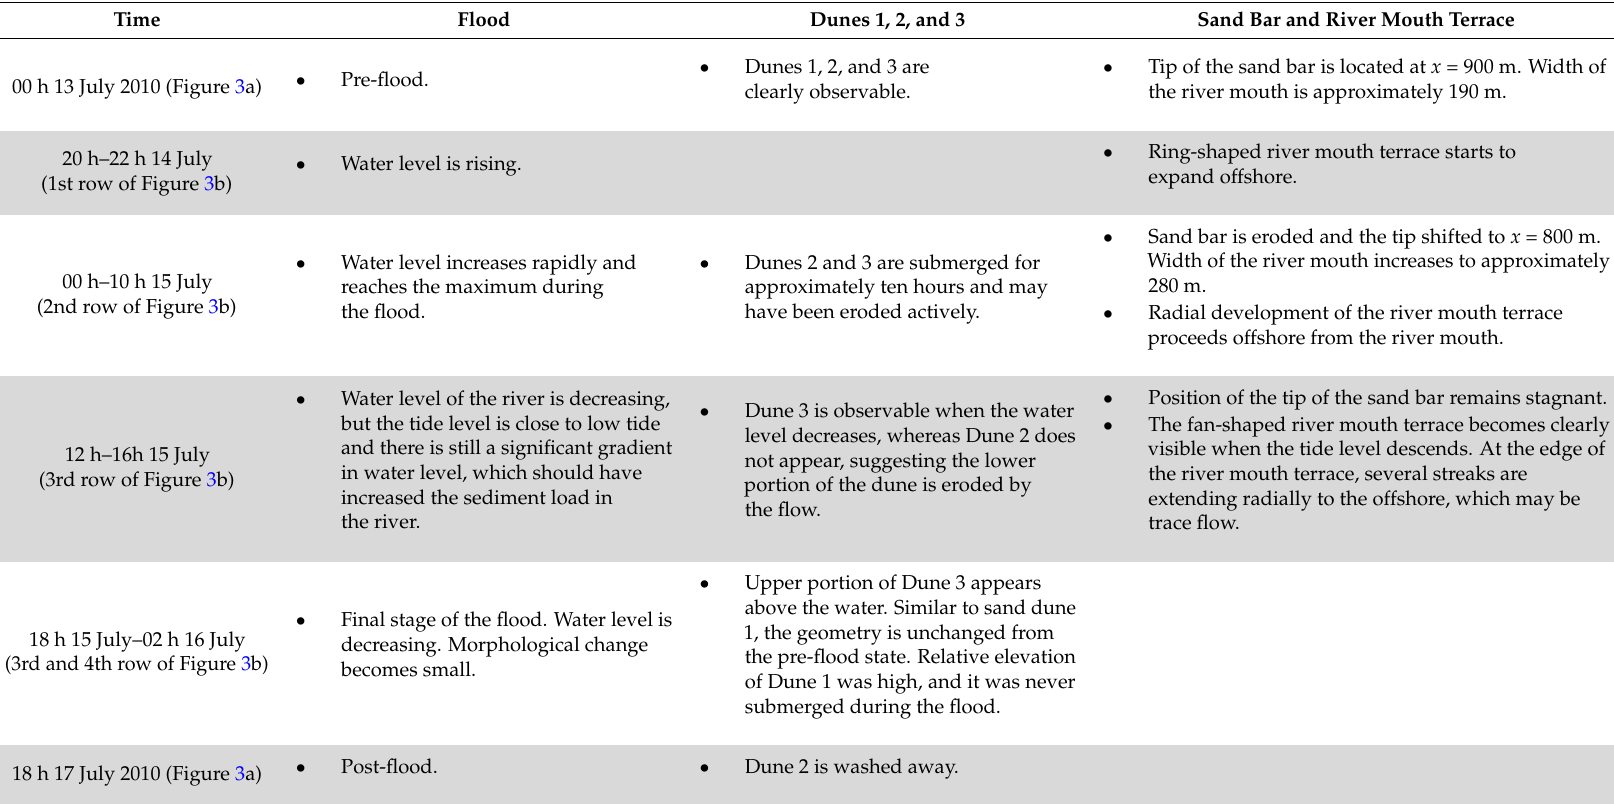
Table 1. Morphological changes during the